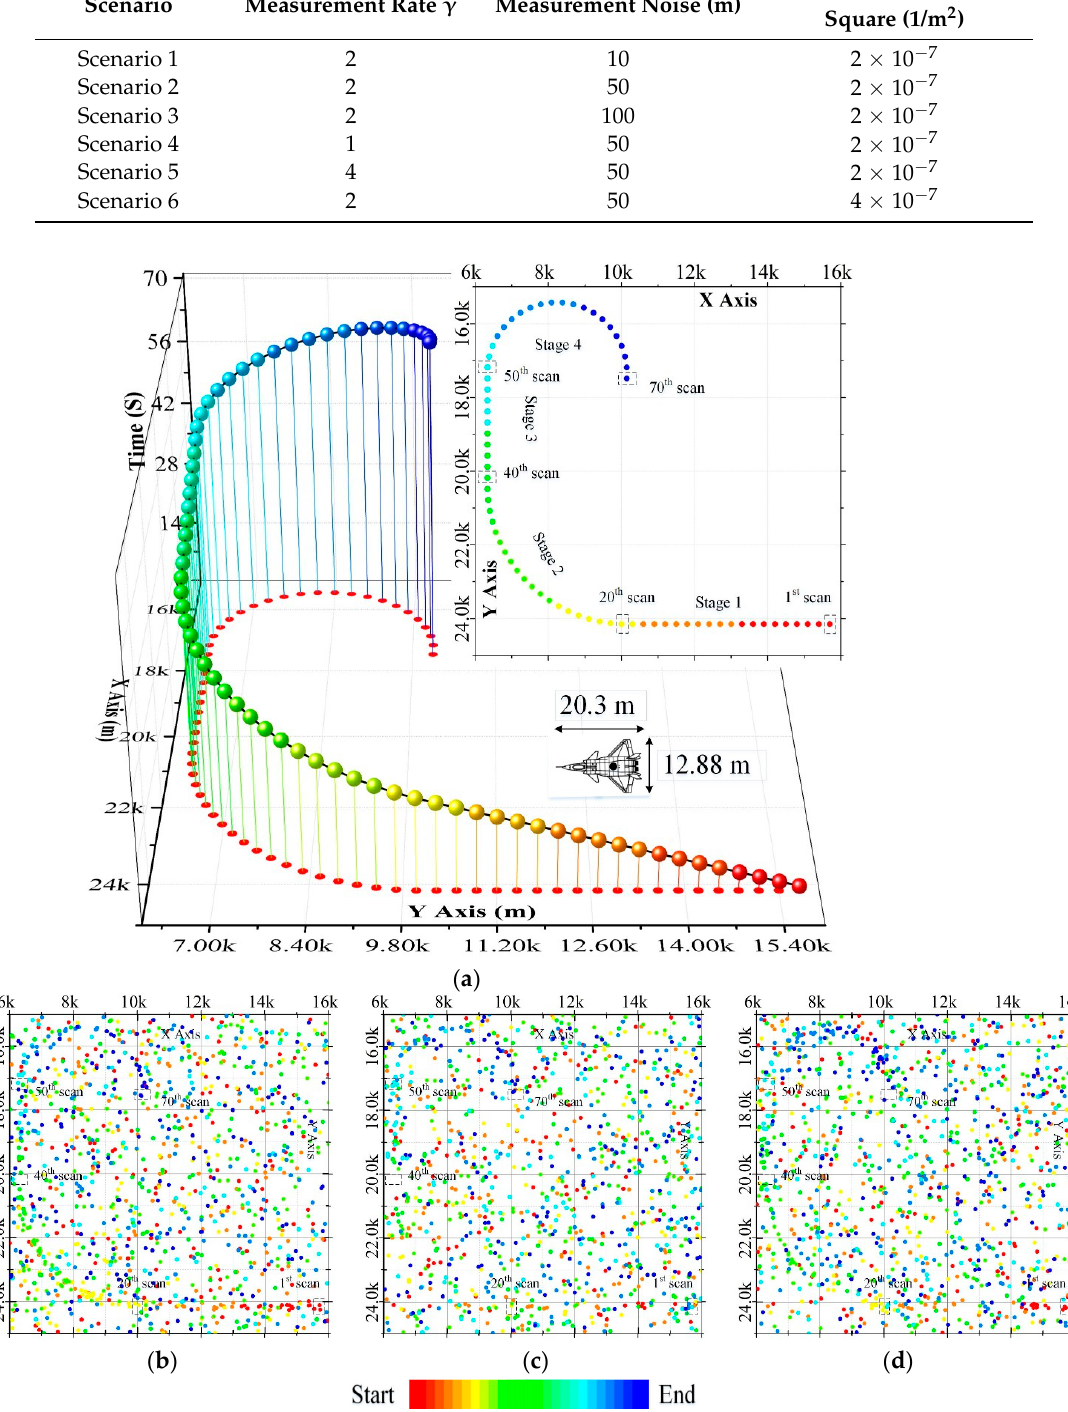
Figure 6. The synthetic data in this work. ( a ) The trajectory of the simulated target. ( b ) The synthetic measurements of scenario 2. ( c ) The synthetic measurements of scenario 3. ( d ) The synthetic measurements of scenario 4.